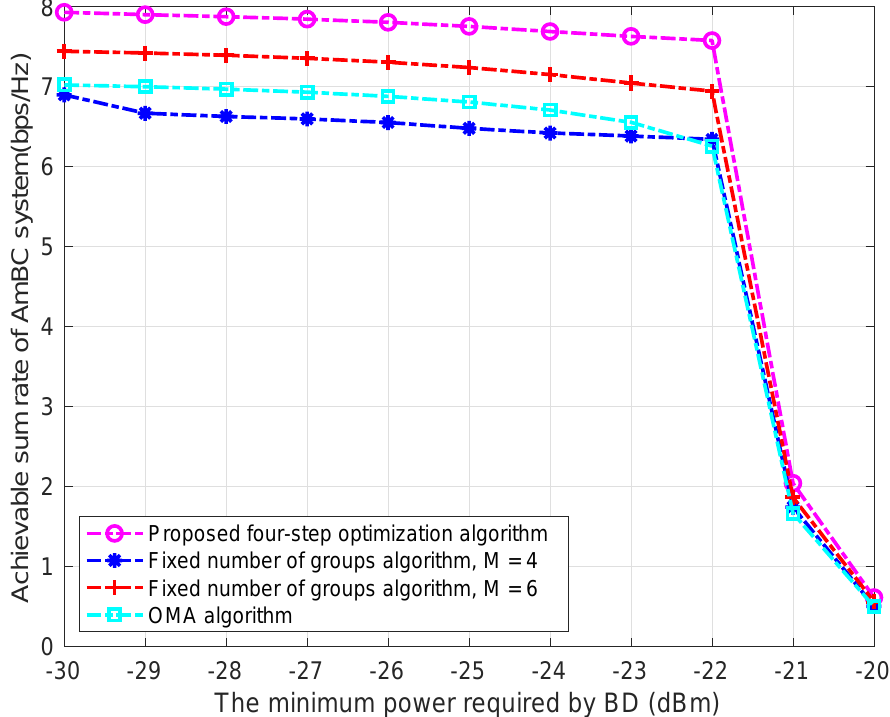
Figure 7. ASR vs. the minimum power required by the BD.